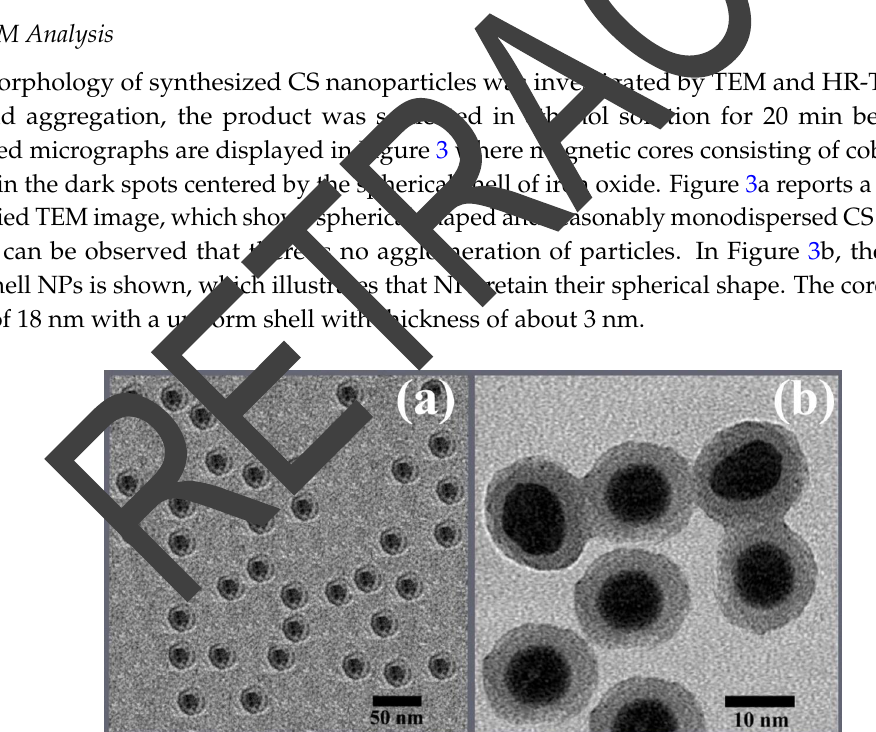
Figure 2. Room temperature Raman spectra of ( a ) core and ( b ) core/shell ferrite nanoparticles.